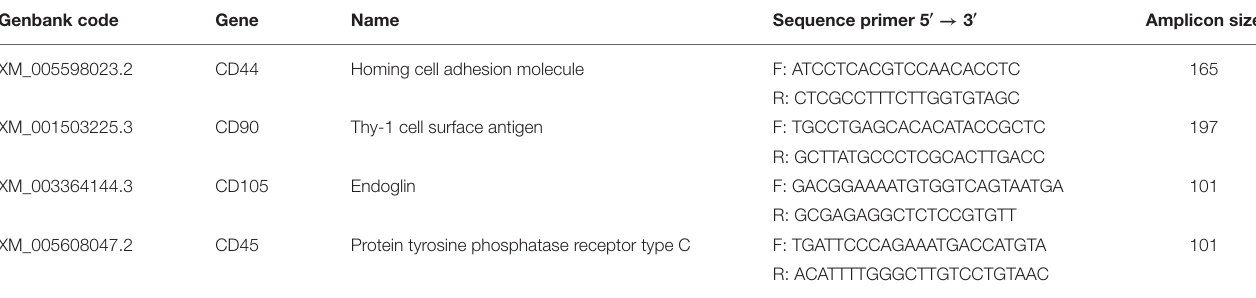
TABLE 1 | Primer sequences used for MSCs culture characterization. Genbank code